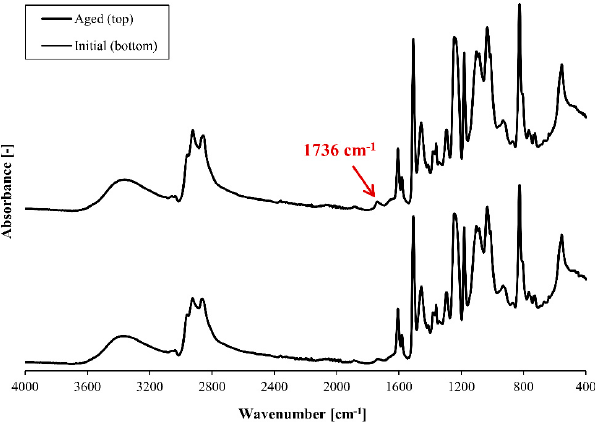
Figure 5. ATR-FT-IR spectra of initial ( bottom ) and redried after hygrothermal process resin ( top ).